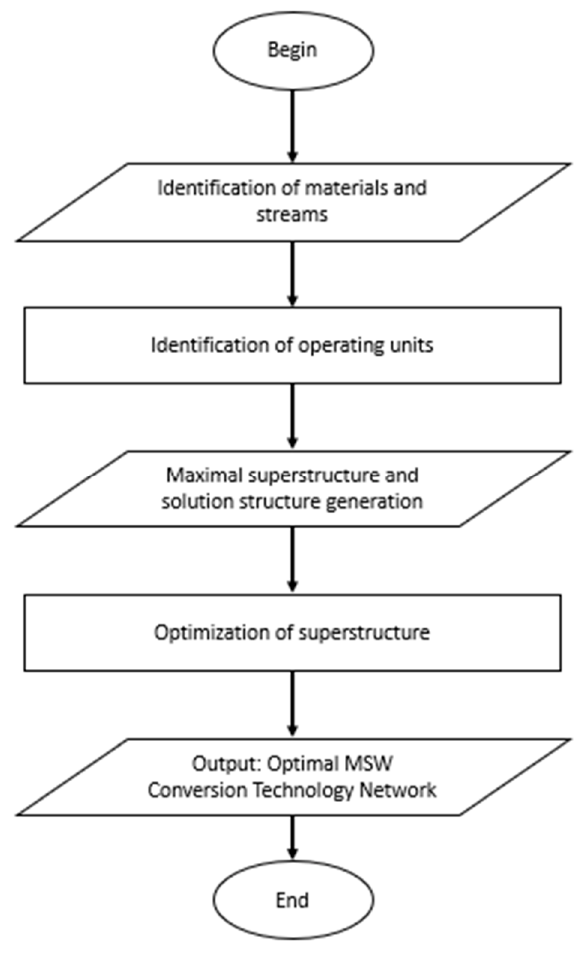
Figure 2. Intracluster synthesis procedure for the process graph (P-graph), reproduced with permission from [36]. Copyright Elsevier, 2010.